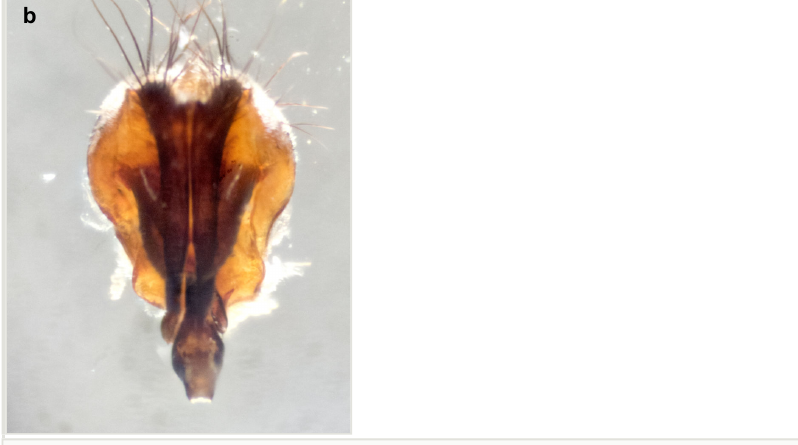
c Figure 12. Male terminalia of Calolydella destituta sp. n. ; a–c : paratype, voucher n.